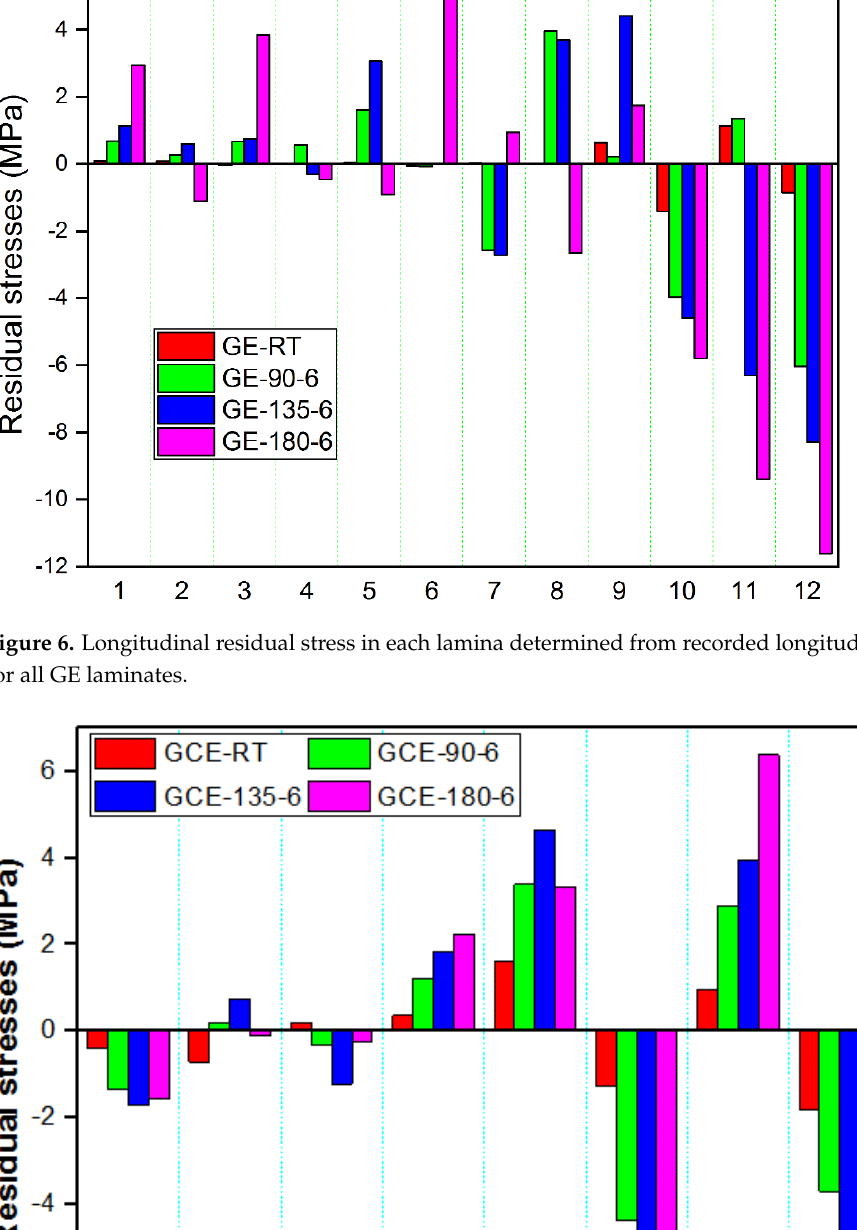
Figure 5. Transverse residual stress in each lamina determined from recorded transverse strains for all GE laminates.